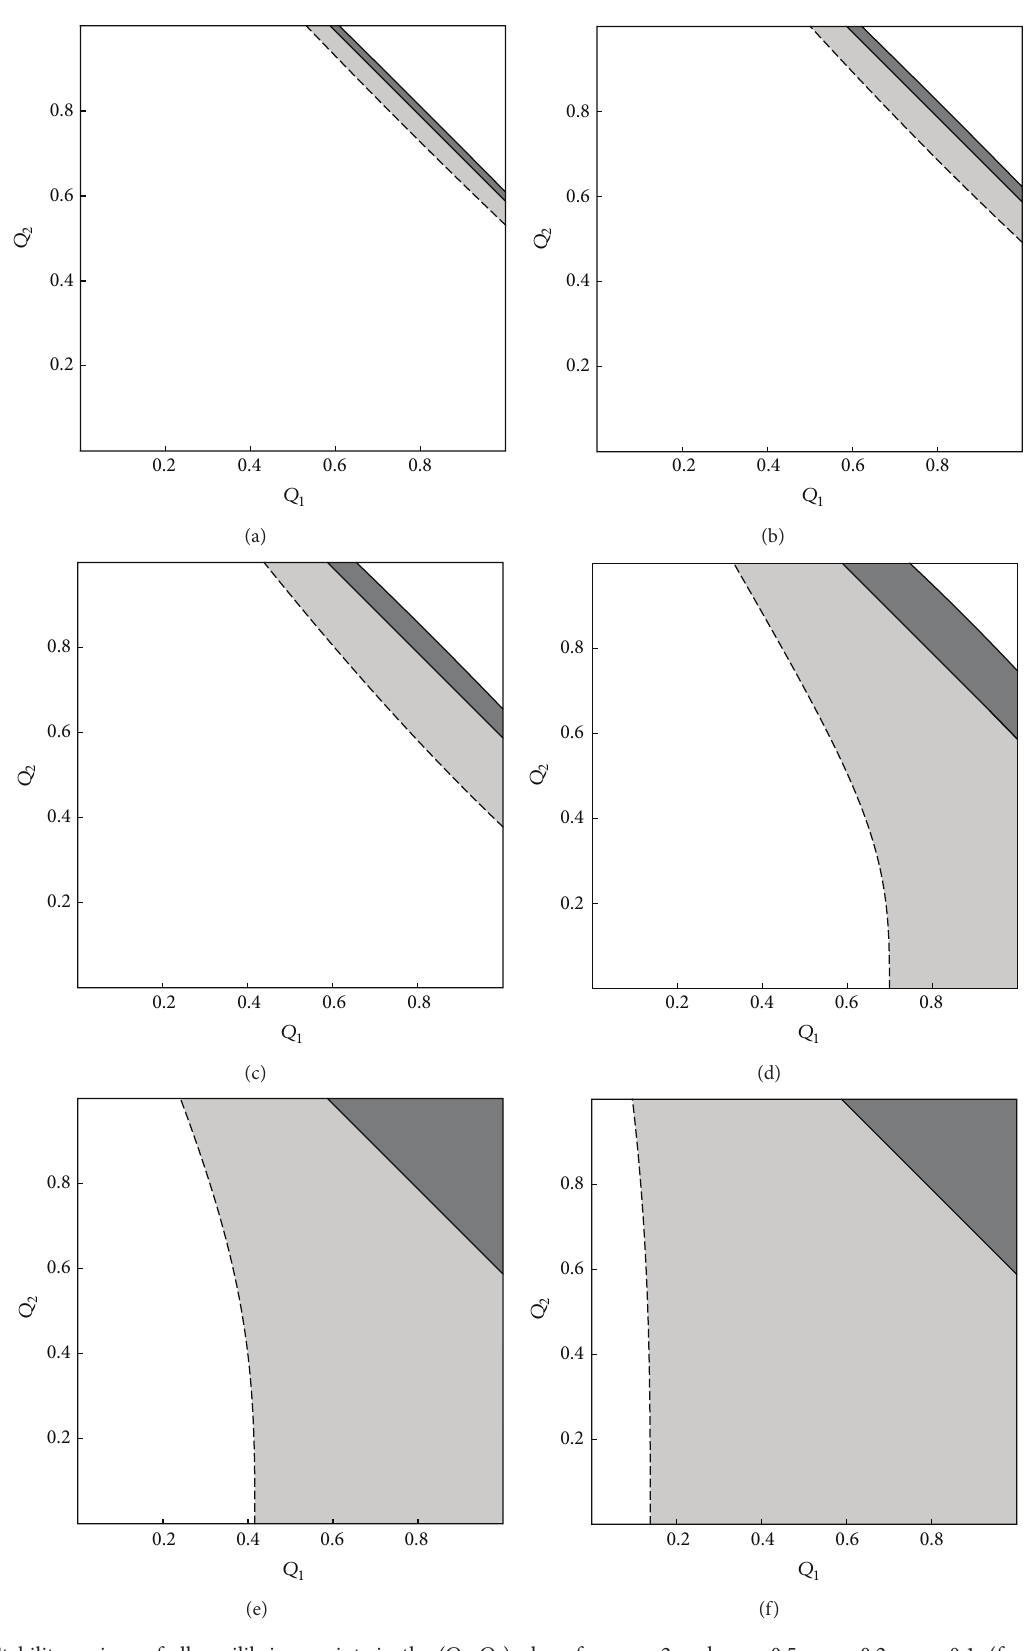
Figure 5: Stability regions of all equilibrium points in the (𝑄 1 , 𝑄 2 ) plane for 𝜔 = 2 and 𝜇 = 0 . 5, 𝜇 = 0 . 2, 𝜇 = 0 . 1, (from (a) to (c)) 𝜇 = 0 . 05, 𝜇 = 0 . 03, and 𝜇 = 0 . 01 (from (d) to